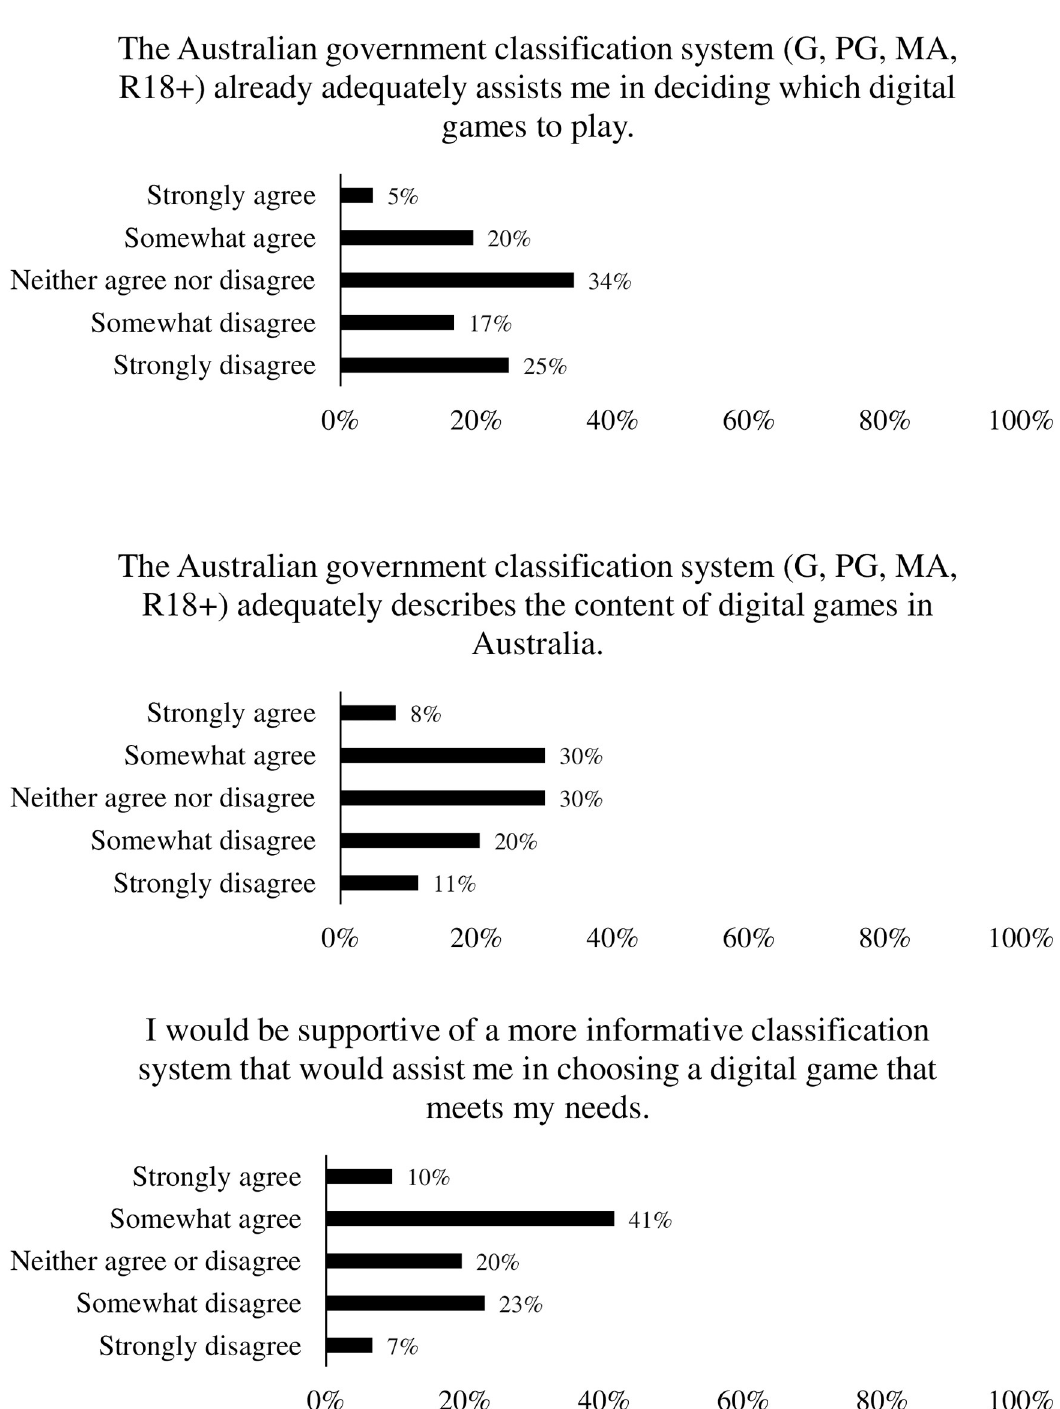
Fig 6. Response distributions for attitudes towards current and potential game classification systems.